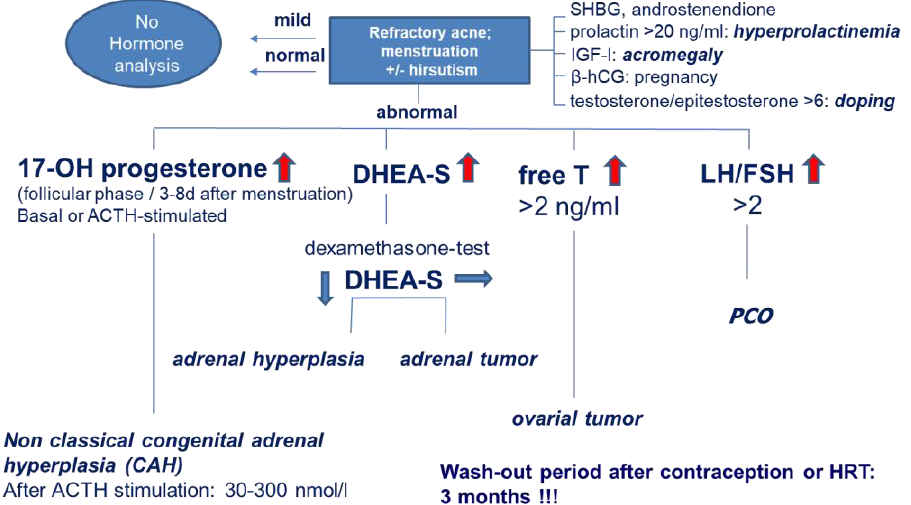
Figure 3. Algorithm of serological hormone tests in patients with suspected hyperandrogenemia. 17- OH-P: 17-hydroxy-progesterone, ACTH: adrenocorticotropic hormone, DHEA-S: dehydroepi-